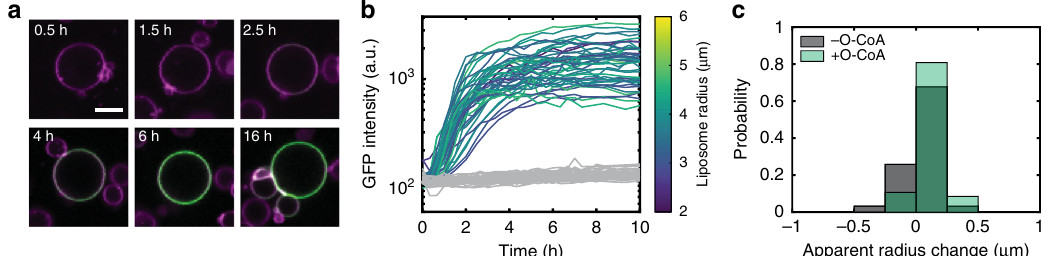
Fig. 6 Kinetics of PS production and probe recruitment. a Time-lapse images of a liposome exhibiting increasing LactC2-eGFP signal over time, as observed for 47 liposomes in three independent repeats. Scale bar is 5 μ m; picture size is identical for all images. b Single-liposome kinetics of LactC2-eGFP binding for 47 PS-synthesizing liposomes, colour-coded with respect to the liposome radius (aggregated data from three independent repeats), and for 28 liposomes in a control sample that does not contain oleoyl-CoA (grey curves). c Probability distributions of the apparent radius change for the liposomes analysed in ( b ). The apparent radius change was determined by calculating the difference between the apparent radius at 0 h and 16 h. Identical imaging settings were used for all acquired data. Source data are available for ( b , c